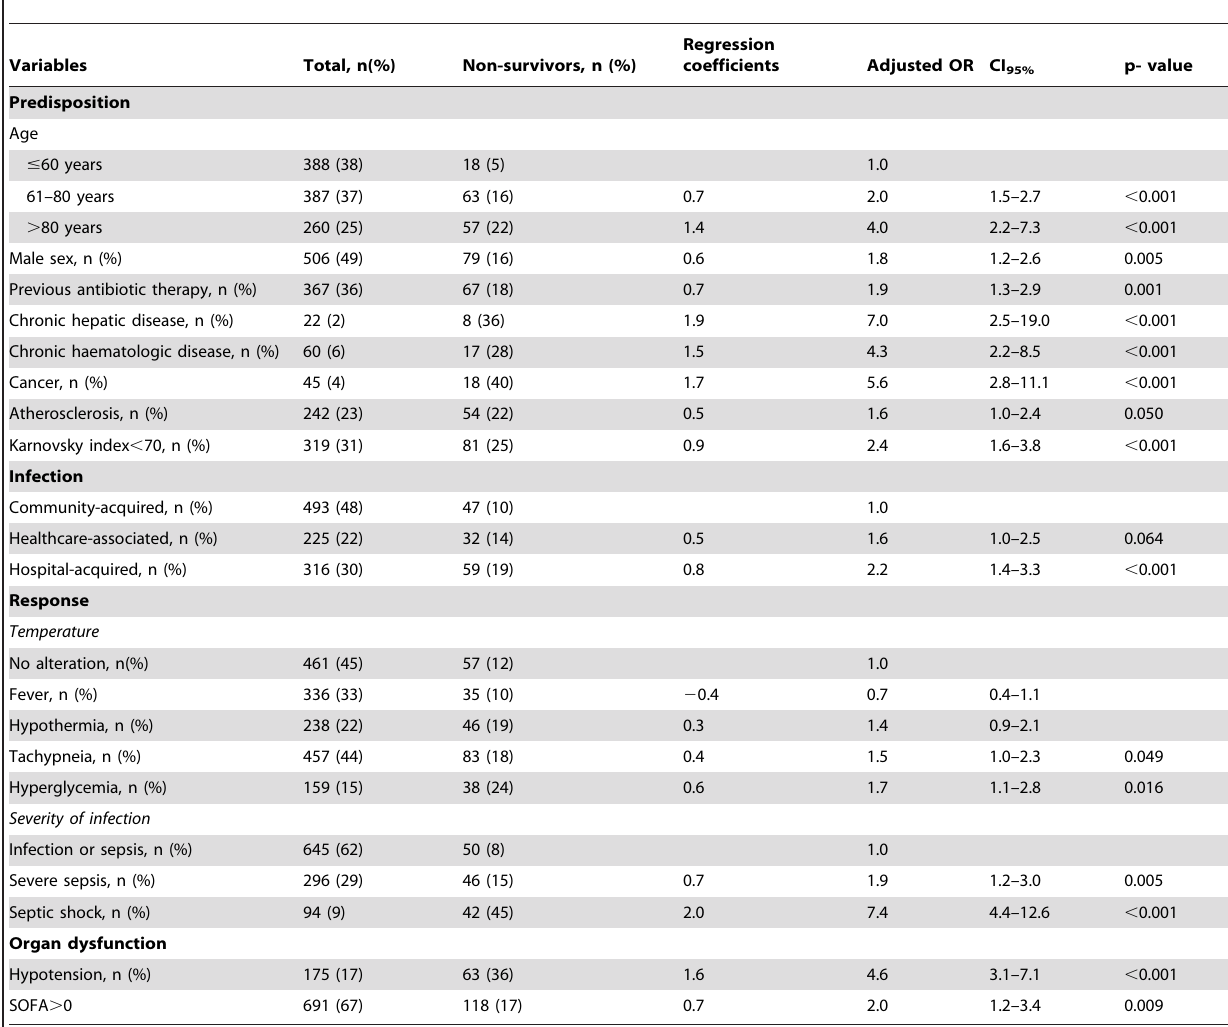
Table 3. Selection of variables significantly associated with hospital mortality using logistic regression, within each of the four components of PIRO.